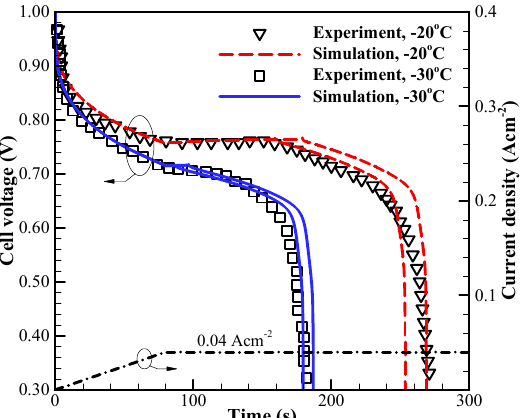
Figure 3. Comparison between the present model and the experimental data 2 (denoted with symbols) with different cold-start temperatures. The dash-dot line denotes the variation of cell operating current density. The corresponding variation of cell voltage at different cold-start temperature is shown with the solid and dashed lines, respectively.